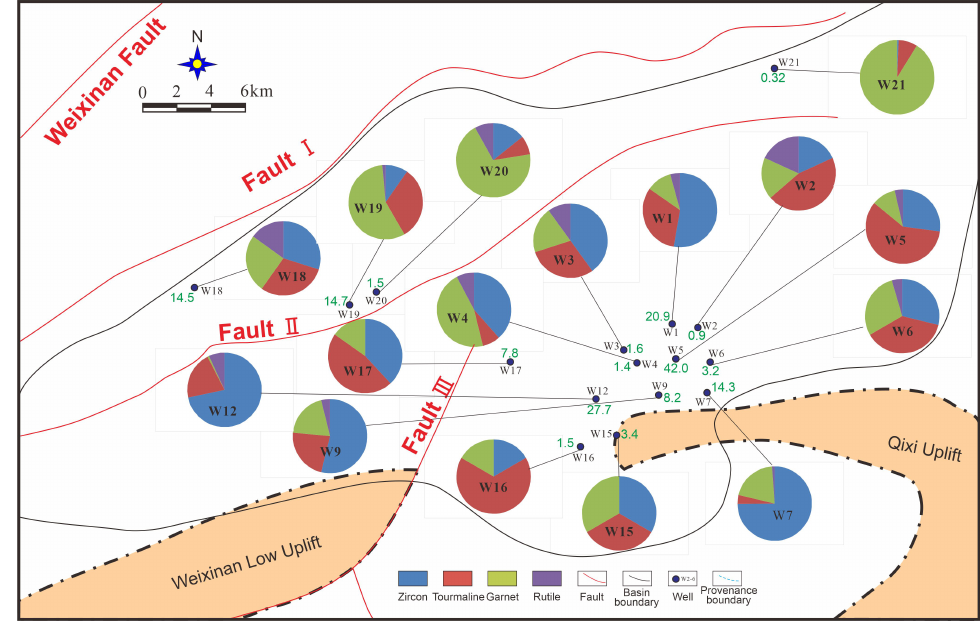
Figure 7. The pie chart of heavy mineral assemblage (zircon + tourmaline + garnet + rutile) percentage and ZTR index of the Mbr2 in the Weixinan sag. The numbers beside the wells are the ZTR values of the